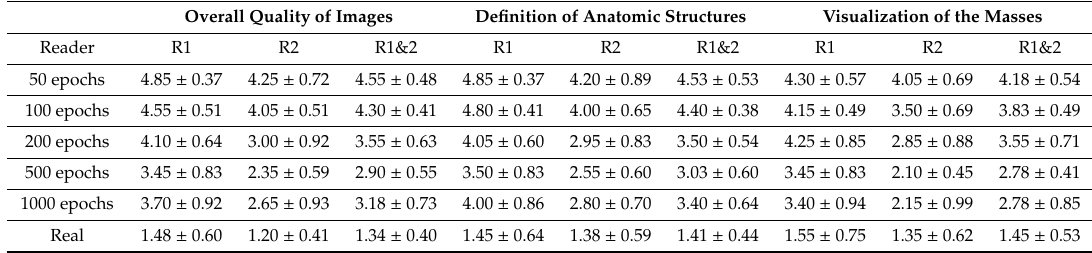
Table 3. Five-point assessment score of synthetic and original